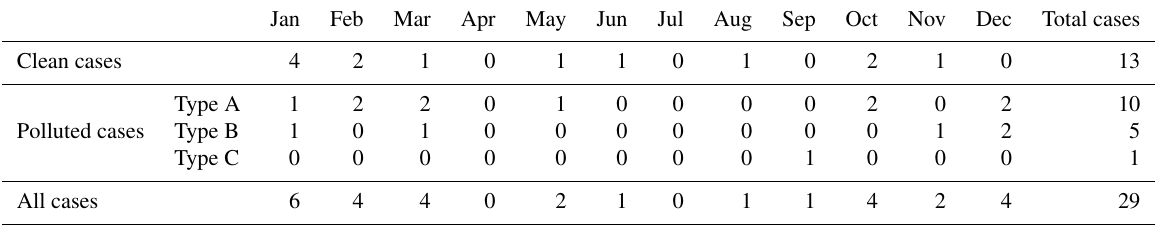
Table 2. Number of foehn cases in Beijing from 1 March 2015 to 29 February 2016. Jan Feb Mar